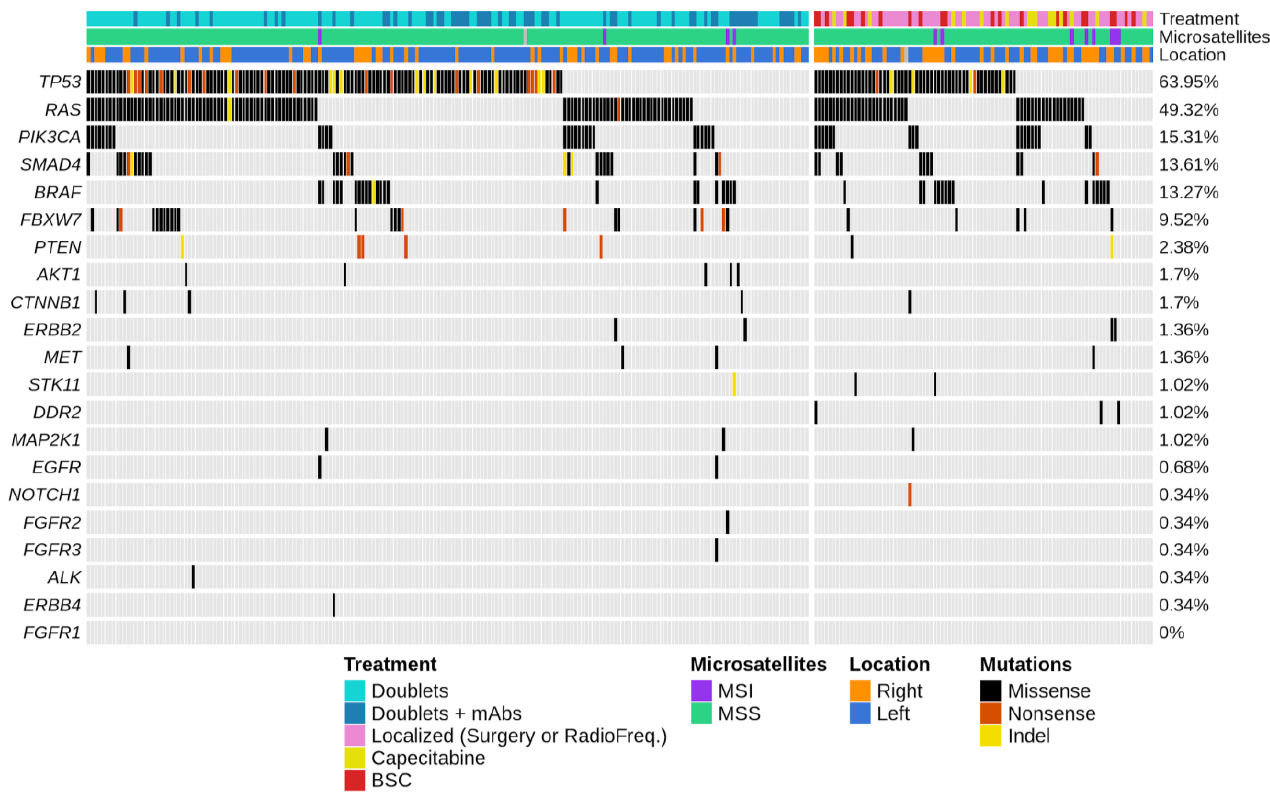
Figure 1. Mutation profiling of actionable and cancer driver genes interrogated by targeted capture – based sequencing in patients with metastatic colorectal cancer. Oncoprint chart illustrating the mutation landscape of the Oncomine Solid Tumor 22 – gene panel, ranked by ordered mutational frequencies (right), for the 294 capture – sequenced colorectal tumors arranged in two groups according to treatment received (i.e., left group comprises N = 200 patients treated with chemotherapy doublets plus/minus monoclonal antibodies, mAbs; right group comprises N = 94 patients treated with other second-line options or BSC). Each row represents a gene and each column an individual tumor sample. Colored bar plots (top) provide data on tumor – related and treatment characteristics annotated in legend (bottom). Table 3. Cox models for PFS/OS stratifying by the annotated mutated genes (individually or in